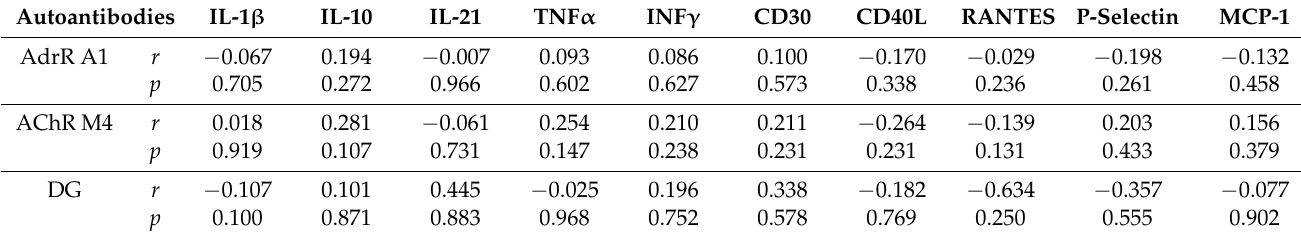
Red font signifies elevations, black signifies normal levels, and blue font signifies decreased values. Table 3. Correlation between cytokines/chemokines, autoantibodies, and platelet dense granules.